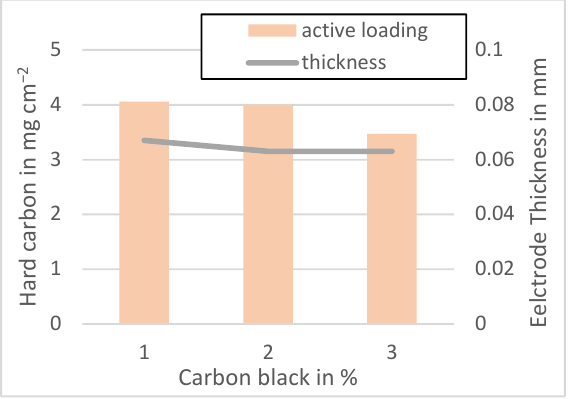
Figure A5. Active material loading of the MTI anodes mixed at 1500 rpm.